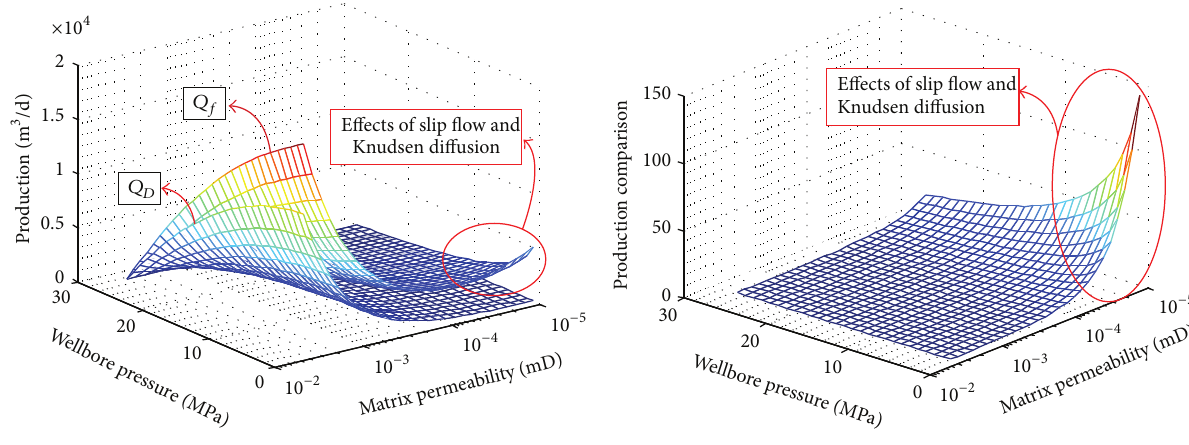
Figure 11: Effects of Knudsen diffusion coefficient 𝐷